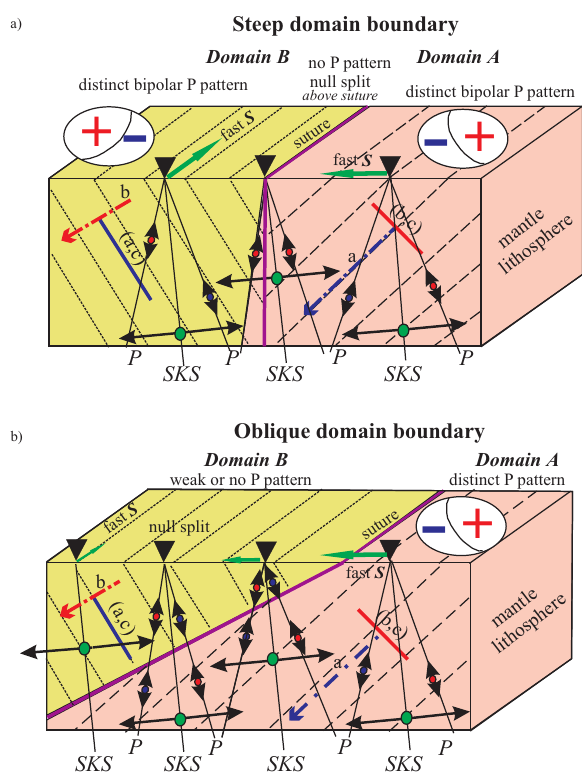
Fig. 5. Schematic fast shear-waves (long arrows perpendicular to rays) and their polarizations (green arrows) along with distribu- tion of early (blue) and delayed (red) P-wave (short longitudinal arrows along rays) arrivals and their projection into the P spheres (schematic bipolar pattern shown) within two blocks with differ- ent orientation of anisotropy. Domain B is characterized by olivine aggregate with hexagonal symmetry b (the b -axis model) and dip- ping high-velocity foliation (a,c) . Domain A is approximated by hexagonal aggregate with dipping lineation a (the a -axis model). Anisotropic signal in shear waves propagating along a near vertical suture disappears (null splitting) or decreases significantly, because the waves sample both structures. If the waves travel across an in- clined suture, we can detect anisotropic signal reflecting a structure, which is consistent in a volume at least comparable with the shear wavelength. The steep suture is marked by an abrupt change in the P sphere pattern, while the oblique suture is reflected as a broader transition with no or weak anisotropic P